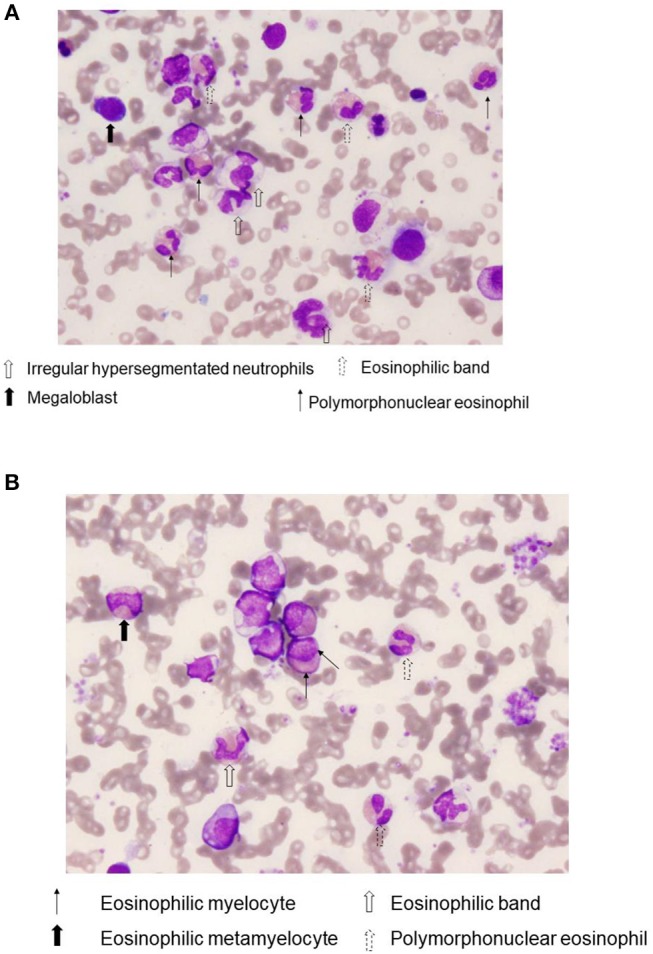
Bone marrow eosinophilia. A representative Wright-Giemsa stain, (×400) of bone marrow aspirate smears from case 1. Notice the presence of various immature eosinophils, including eosinophilic band and Polymorphonuclear eosinophils (A), as well as eosinophilic myelocyte and eosinophilic metamyelocyte (B).